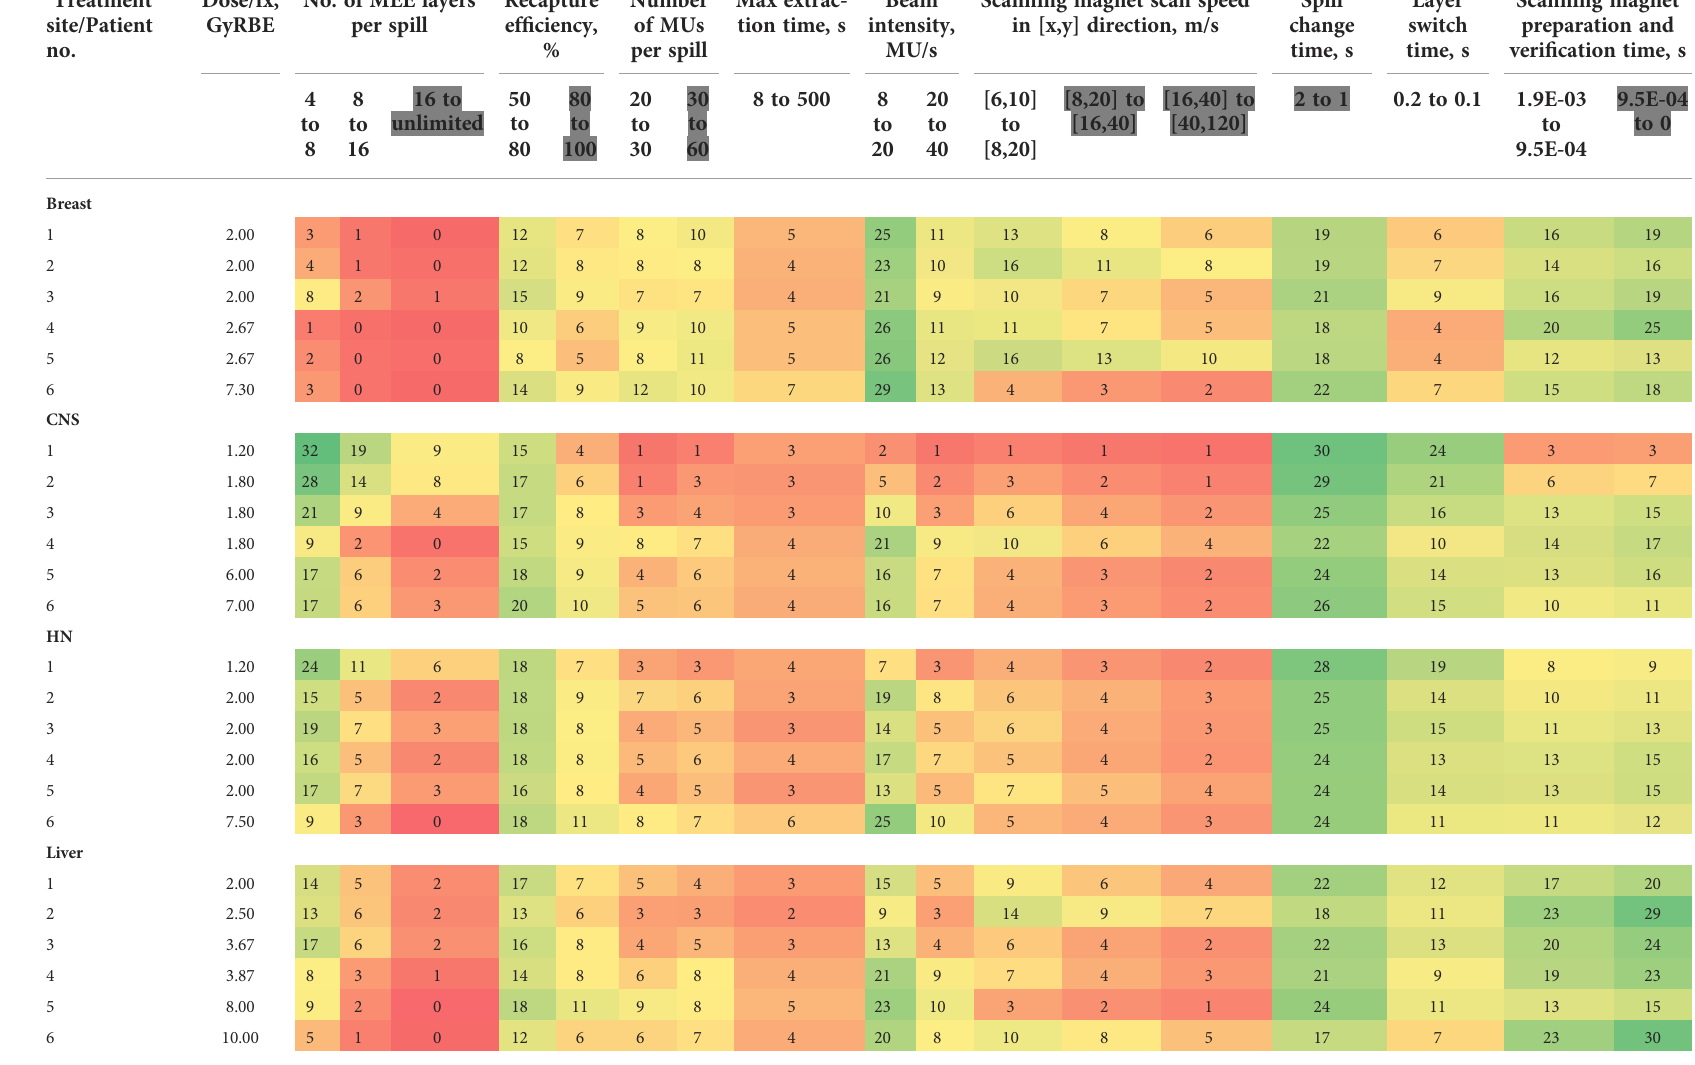
TABLE 3 Mean beam delivery time (BDT) percentage reduction with improved operating parameters for 36 representative treatment plans. Treatment